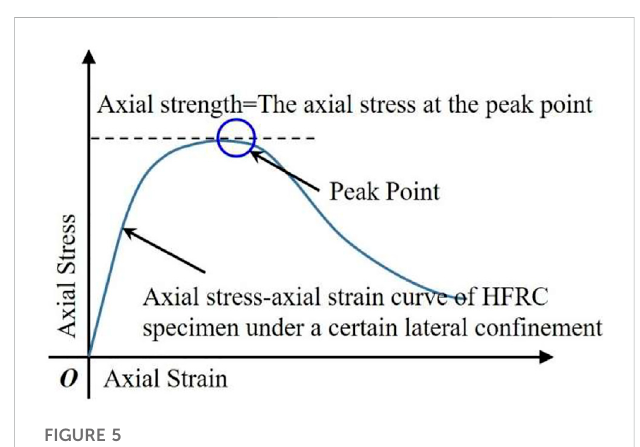
FIGURE 5 Sketch of the de fi nition of axial